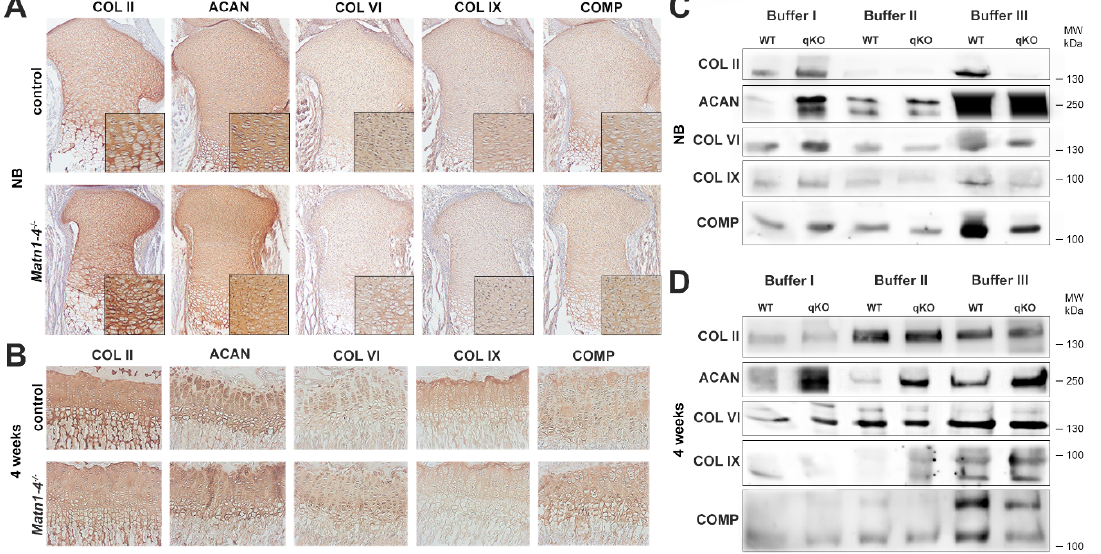
Figure 5. Immunohistochemical and biochemical analysis of the deposition and solubility of the binding partners of matrilins. Immunohistochemistry at newborn ( A ) and 4 weeks ( B ) stages indicates no apparent differences in the deposition of collagen II (COL II), collagen VI (COL VI), collagen IX (COL IX), aggrecan (ACAN) and cartilage oligomeric matrix protein (COMP) between control and Matn1-4 − / − mice. Original magnifications: × 10 for ( A ) and ( B ); x 20 for inserts in ( A ). Western blot analysis of cartilage extracts in newborn ( C ) and 4 weeks old ( D ) animals. In newborn, slightly increased extractability of collagen II, collagen IX, aggrecan, collagen VI and COMP in buffer I and significantly weaker signals for collagen II, collagen IX and COMP were detected in fraction III isolated from the cartilage of quadruple knockout mice compared with controls ( C ). At 4 weeks, the amount of aggrecan is increased in all fractions, the amount of collagen IX is slightly increased in fraction II and the amount of COMP is moderately decreased in fraction III in M Matn1-4 − / − mice compared with the control ( D ). Abbreviation: MW-molecular weight marker.